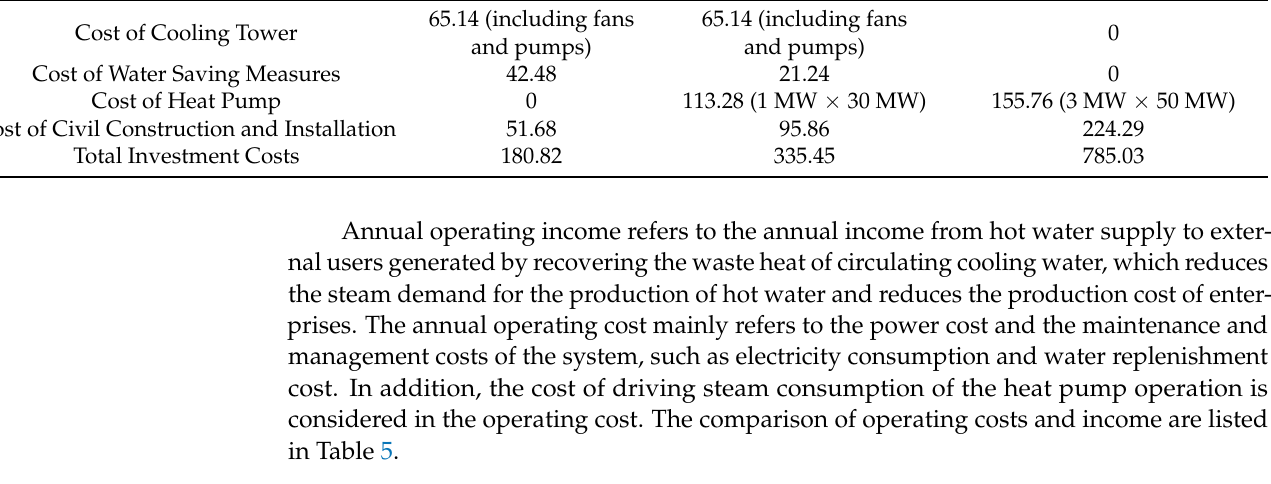
Table 5. Comparison of annual operating costs and annual income (unit: million